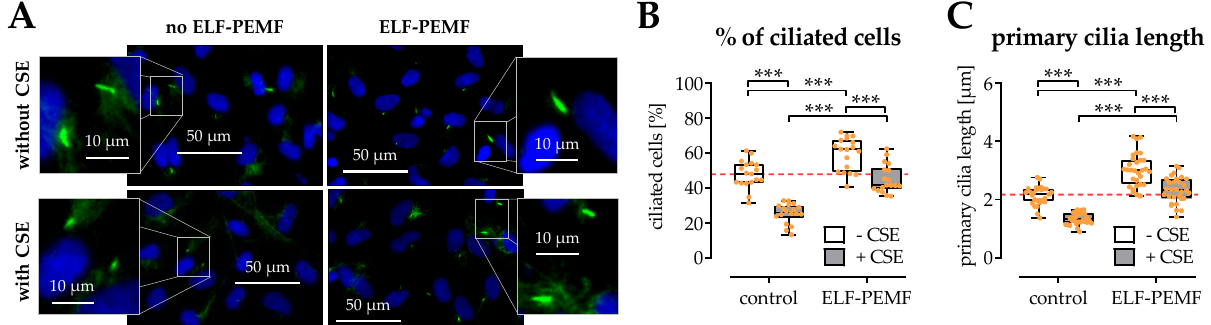
Figure 6. The structural integrity of primary cilia is affected by exposure to 5% cigarette smoke extract (CSE) and rescued by exposure to 16 Hz ELF-PEMFs for 5 days and 30 min daily. ( A ) Primary cilia were visualized by immunofluorescence staining for acetylated tubulin (green). Nuclei were counterstained with Hoechst 33,342 (blue). Fluorescent images were analyzed with the ImageJ software, to determined ( B ) the amount of ciliated cells in percent and ( C ) the length of the primary cilia. N = 3, n = 3. Data are presented as box plots (Min to Max with single data points). Data were compared by non-parametric two-way ANOVA followed by Tukey’s multiple comparison test: *** p < 0.001 as